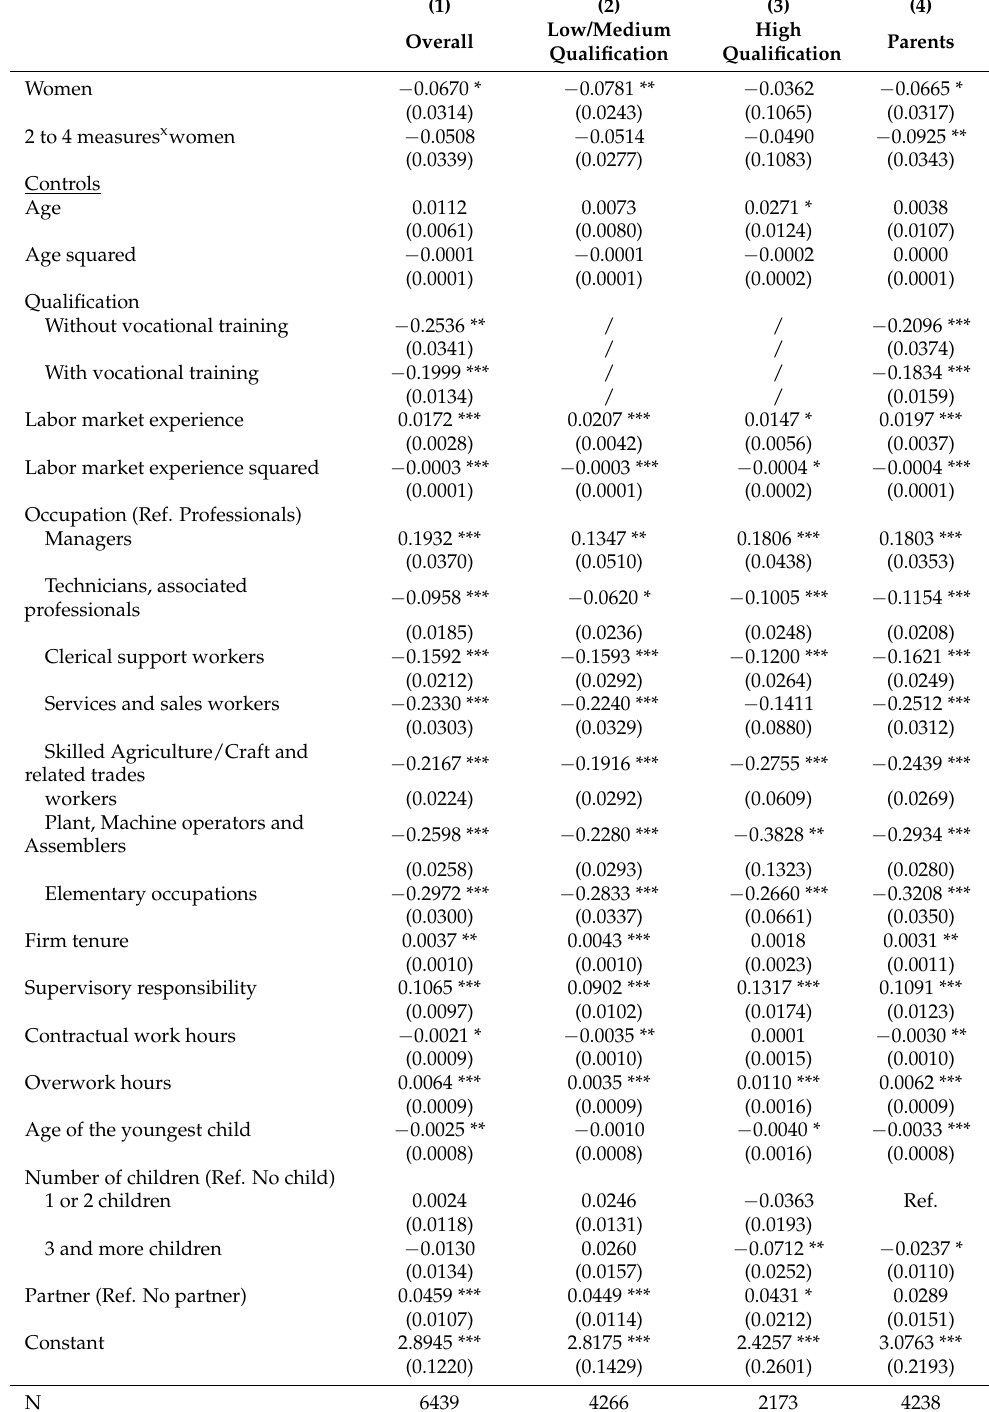
Table A7. The association of multiple WLM and log hourly wages (extended version of Table 4, step